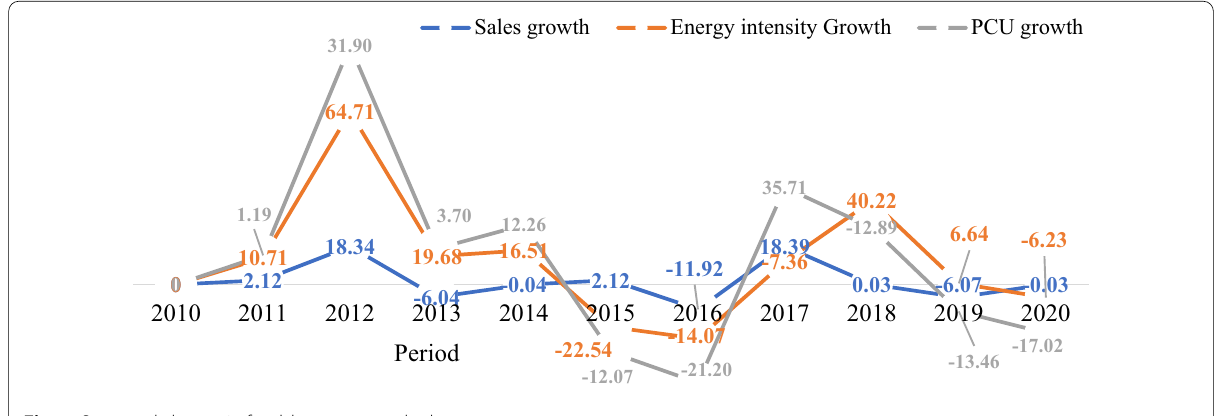
Fig. 7 Structural change in food, beverages and